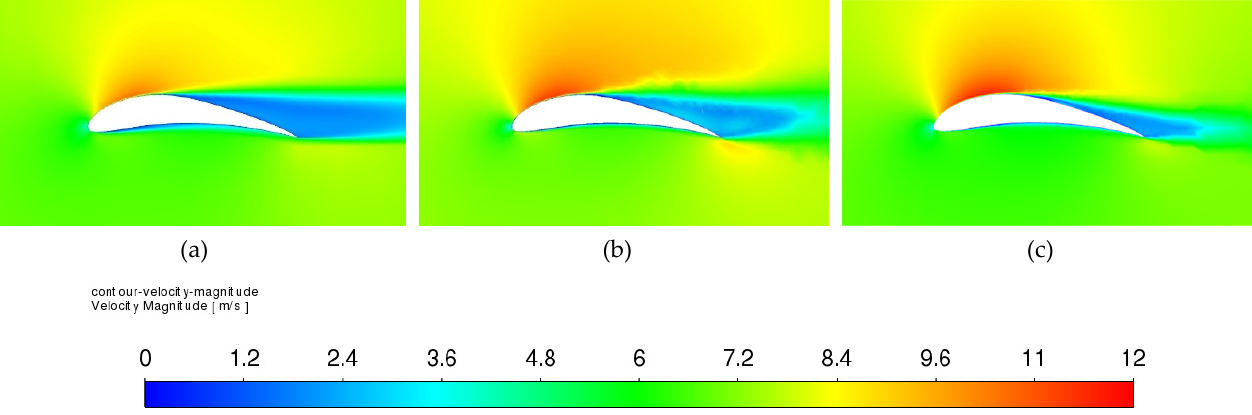
Figure 14. Velocity magnitude around airfoil at 75% of wingspan, angle of attack 20 degrees ( a ) structured mesh ( b ) unstructured mesh ( c ) mosaic poly-hexcore